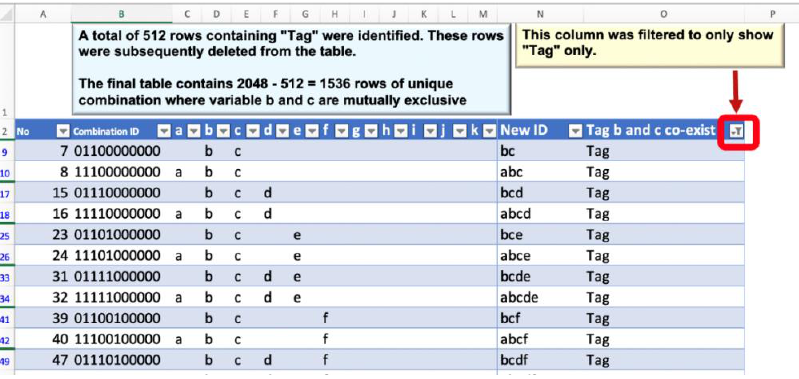
Figure 4. Removing the combinations which contain the mutually exclusive predictors.